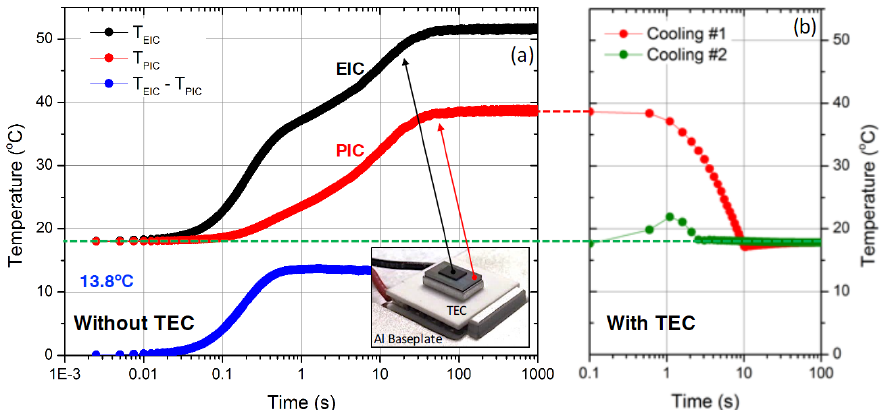
Figure 15. Temperature changes of the EIC and PIC in the FP7 ‐ FABULOUS optical network unit (ONU) from the thermal microscope analysis; ( a ) The increase in EIC and PIC temperature, when the ONU is powered ‐ up, and the TEC (thermo ‐ electric cooler) is not activated. After 30 s, the PIC temperature reaches a steady ‐ state at 20 °C above the ambient; ( b ) Once the TEC is activated (in Cooling#1), the hot PIC rapidly returns to the ambient set ‐ point temperature, reaching ±0.1 °C of the set ‐ point in 30 s. In Cooling#2, the ONU and TEC are powered ‐ up at the same moment, and the PIC never exceeds the set ‐ point by more than 5 °C.